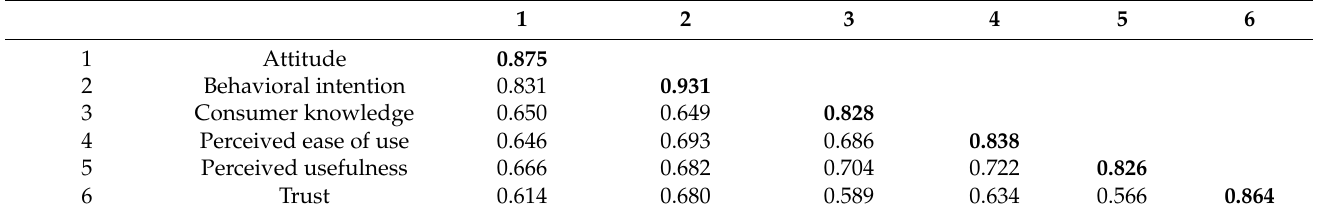
Table 4. Fornell–Larcker